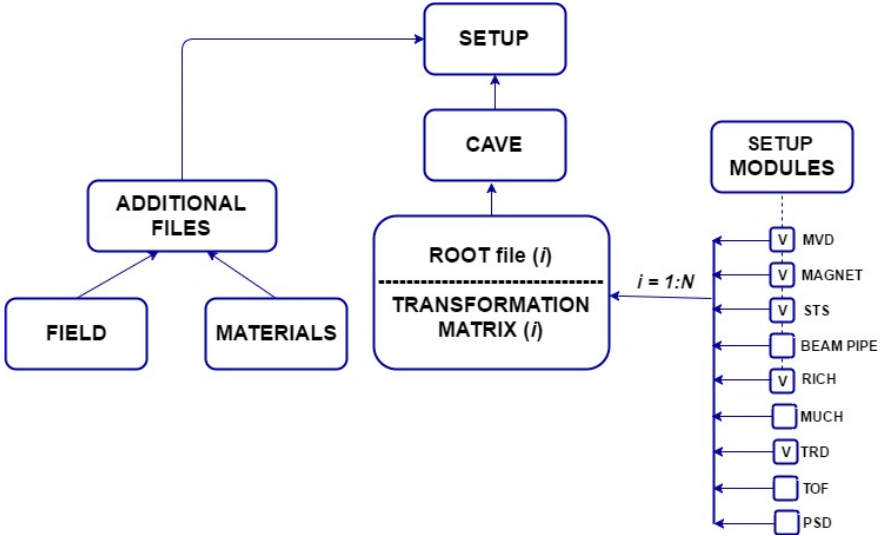
Fig. 1. The structure of the CBM setup